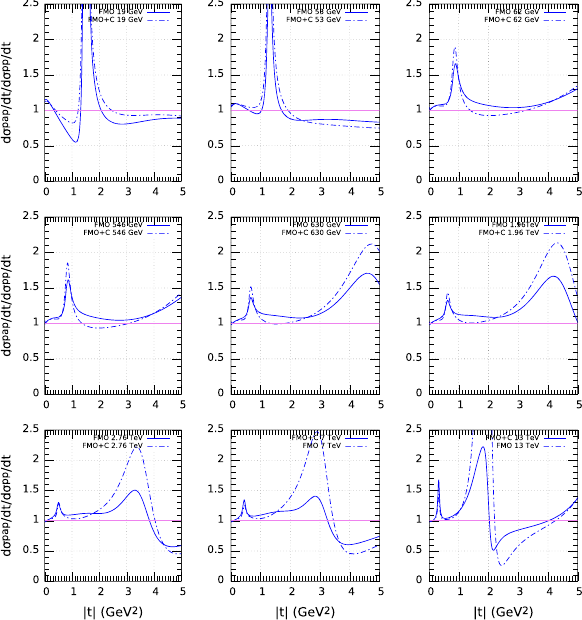
Fig. 11 Evolution of the ratio of differential cross sections R σ = ( d σ( ¯ pp )/ dt )/( d σ( pp )/ dt ) with